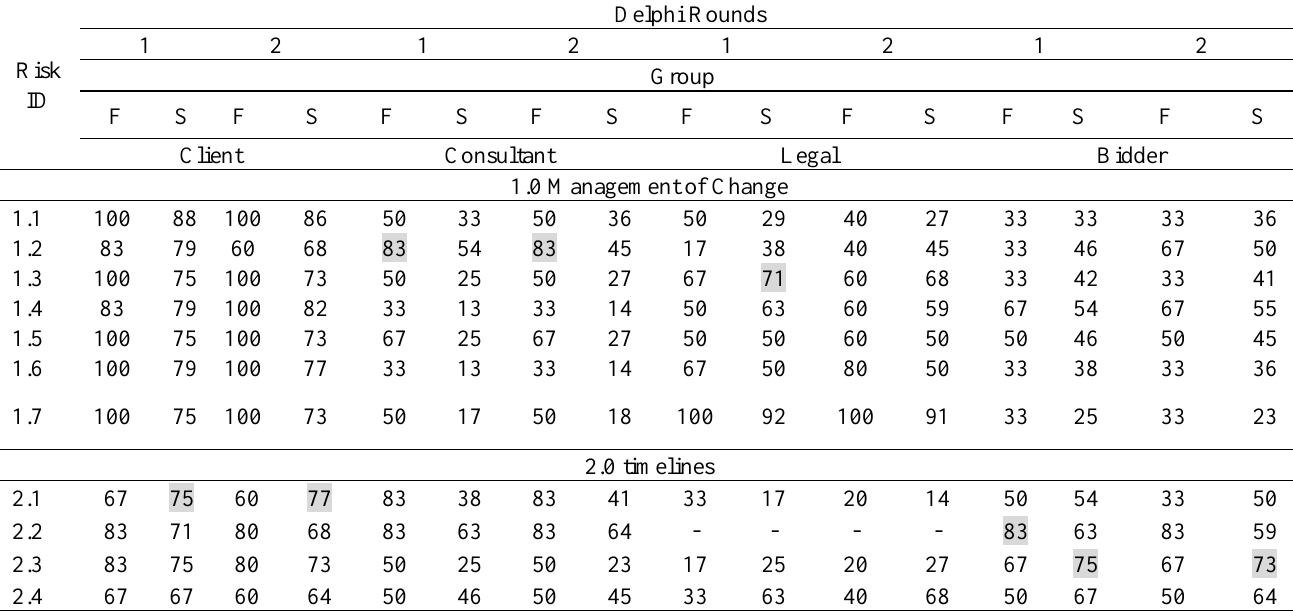
Results of Delphi